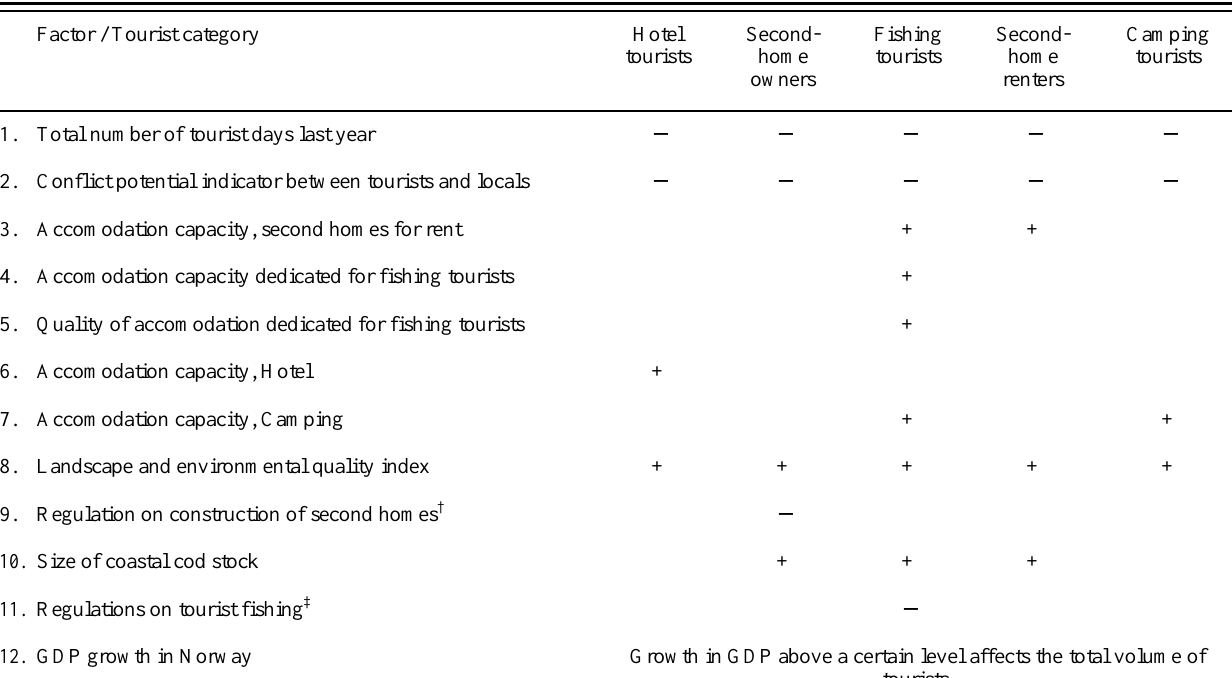
Table 1. How increased values of factors influence the number of tourist days per year in the different tourist